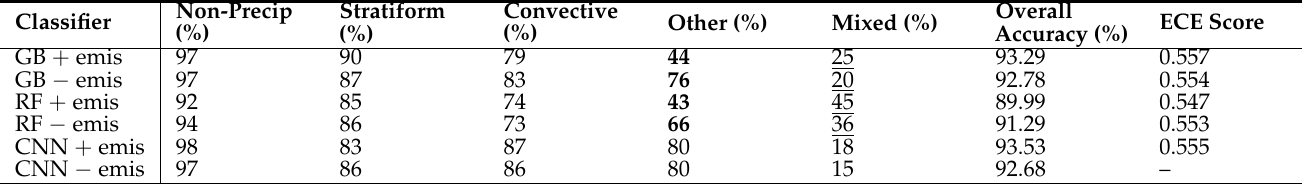
Table 3. Accuracy rate (%) with including emissivity and without emissivity in the training process for each precipitation class for GB, RF and CNN model from independent tests. The uncertainty score using the ECE method is listed in the last column, where we did not compute the score for “CNN-emis” model. See text in Section 3.1 for details of the uncertaincy